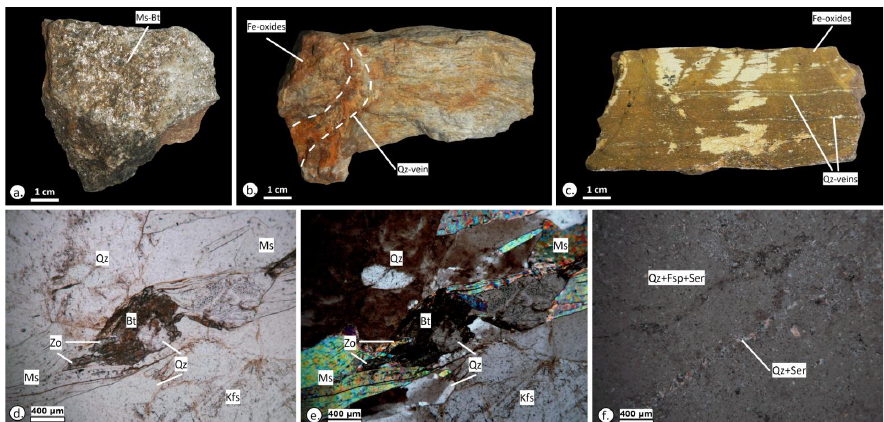
Figure 6. Hand specimens ( a – c ) and photomicrographs (plane polarized light: ( b ); cross-polarized light: ( e , f )) of the two-mica gneiss from Rizana: ( a ) Lustrous muscovite (Ms) and biotite (Bt) parallel to schistosity; ( b ) A quartz (Qz) vein crosscutting a discolored and oxidized (Fe – oxides) two-mica gneiss; ( c ) extensively altered rock mass bearing wide Fe – oxides impregnations and hydrothermal quartz (Qz) veins developed along schistosity; ( d , e ) Muscovite (Ms) and biotite (Bt) intergrown with quartz (Qz) and K – feldspar (Kfs) and minor zoisite (Zo); ( f ) Quartz (Qz) and sericite (Ser) in a hydrothermal vein crosscutting a deformed ground mass containing quartz (Qz), feldspar (Fsp) and sericite (Ser).